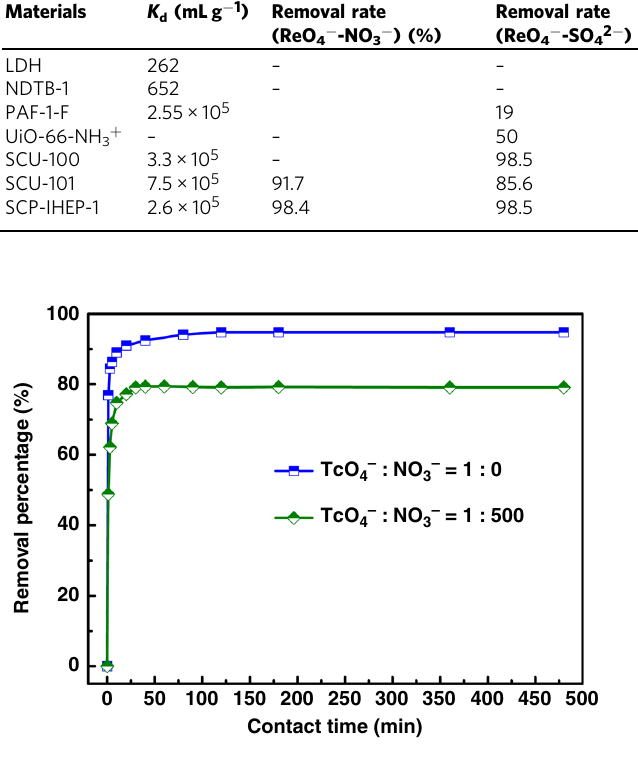
Fig. 5 Removal of TcO 4 − as a function of contact time in the absence of competing anion NO 3 − (blue line; TcO 4 − : NO 3 − = 1: 0, c 0 = 10 mg L − 1 , V = 40 mL, m = 20 mg, and pH = 7.00) and in the presence of 0.03 M NO 3 − (green line; TcO 4 − : NO 3 − = 1: 500, c 0 = 10 mg L − 1 , V = 10 mL, m = 5 mg, and pH = 6.89). Error bars represent the s.d. of